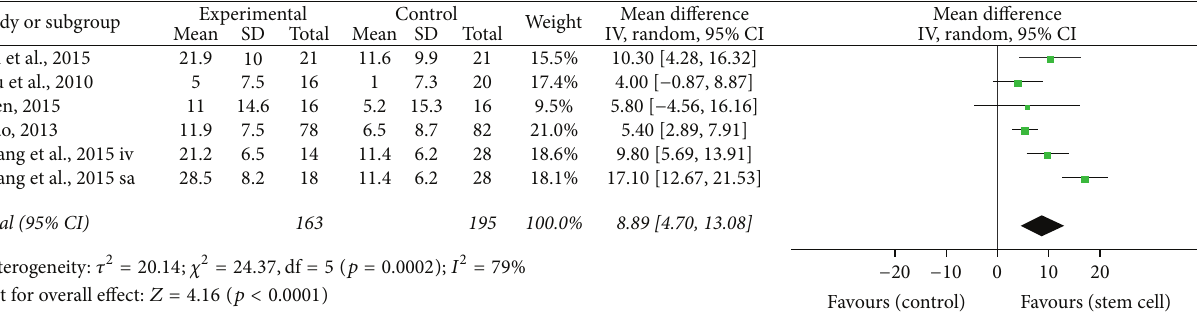
Figure 5: The effect size of improved FIM across studies by meta-analysis.